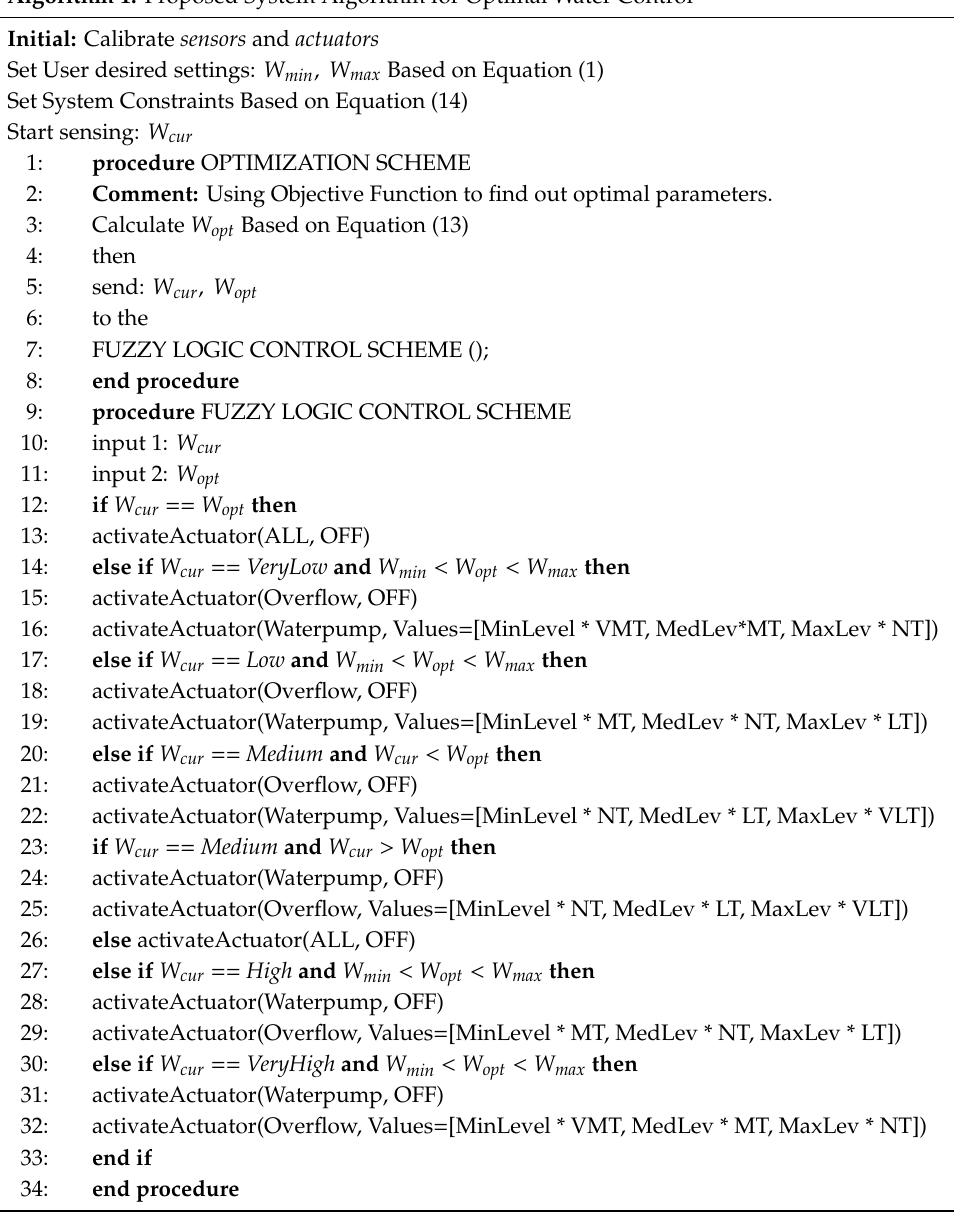
Algorithm 1. Proposed System Algorithm for Optimal Water